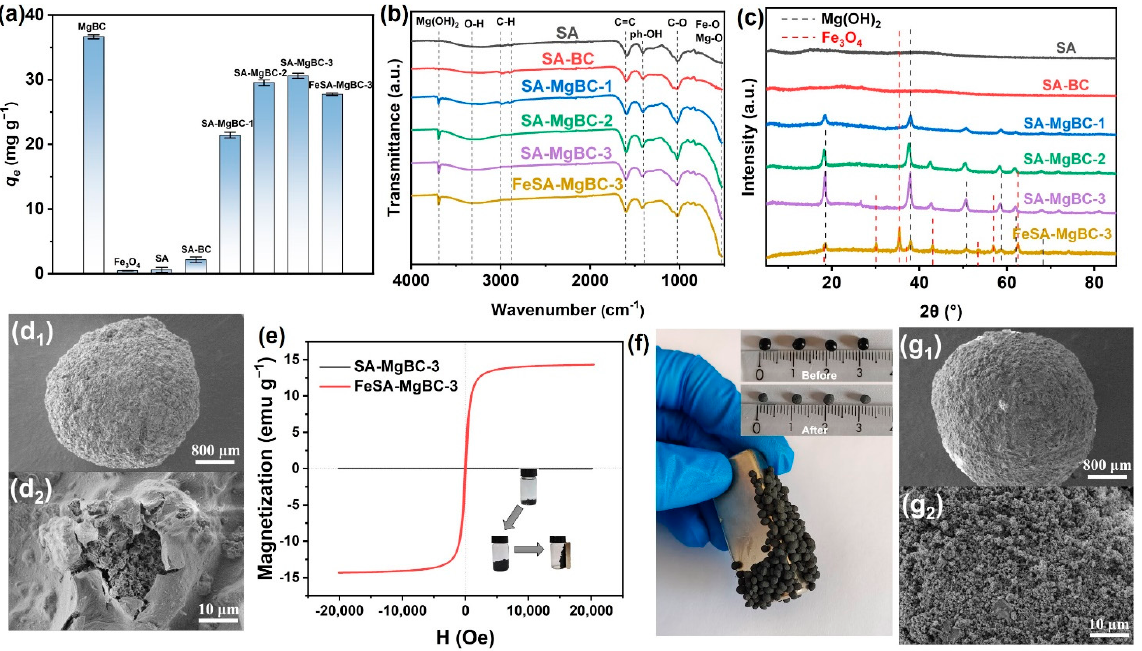
Figure 3. Characterizations of bead adsorbents. ( a ) q e of bead adsorbents for PO 4 -P, ( b ) FT-IR and ( c ) XRD spectra of bead adsorbents, ( d ) SEM images of SA-MgBC-3, ( e ) magnetic hysteresis loops of SA-MgBC-3 and FeSA-MgBC-3 at room temperature, the inset is the photograph showing its magnetic separability, ( f ) macroscopic photograph of the magnetic bead adsorbent attracted to the magnet, the inset is the photograph showing changes of gel microspheres before and after lyophilization, and ( g ) SEM images of FeSA-MgBC-3.